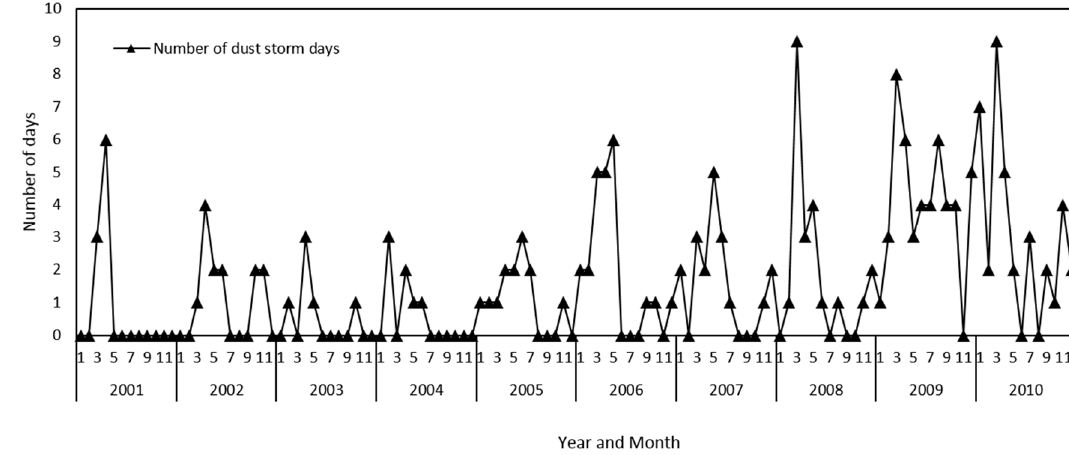
Figure 7. The annual and monthly distribution of dust storm days at Saikhan-ovoo site.